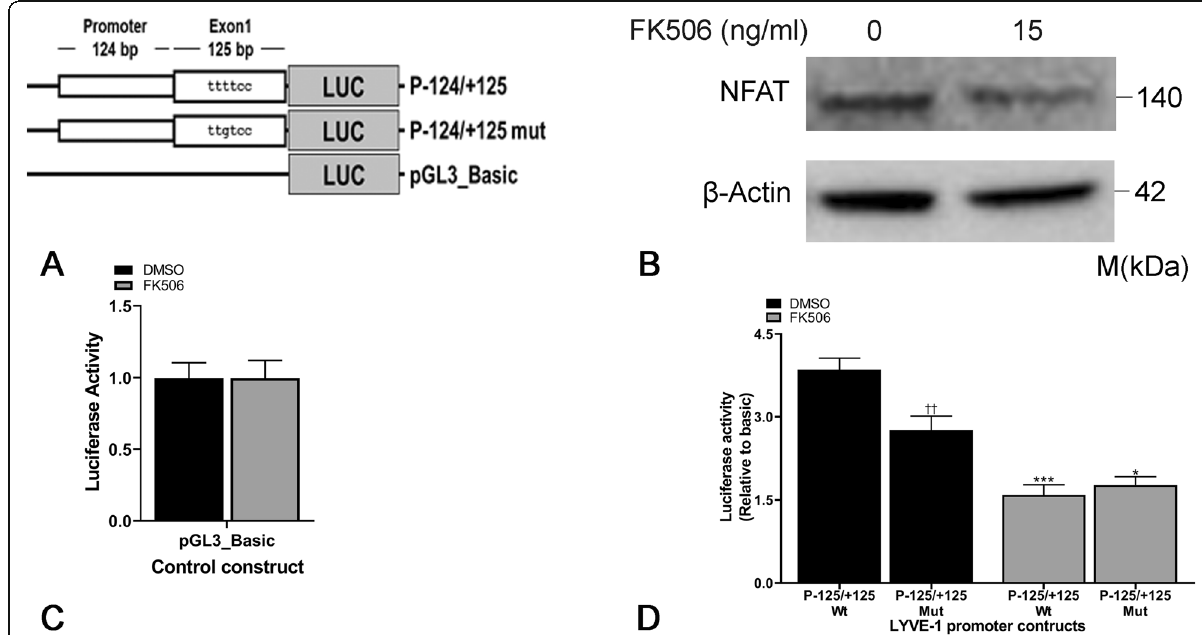
Fig. 4 Luciferase activity of LYVE-1 promoter expression constructs. Schema of pGL3_Basic vector, and wildtype and mutant LYVE-1 luciferase promoter constructs transfected into HEK-293T cells ( a ). Endogenous NFAT expression in HEK-293 T cells ( b ). Luciferase activity of vehicle (DMSO) and FK506 treated HEK-293 T cells transfected with ( c ) pGL3_Basic vector and ( d ) wildtype and mutant LYVE-1 promoter constructs. Each luciferase data is normalized to internal Renilla control. Data for LYVE-1 promoter constructs are presented relative to the pGL3_Basic vector luciferase activity. Average (± standard deviations as error bars) of four independent experiments are presented; each independent experiment for western blotting consisted of three technical replicates. *** p < 0.0001 (between P-125/+ 125 wildtype DMSO vs. FK506), * p < 0.05 (between P- 125/+ 125 mutant DMSO vs. FK506), †† p < 0.001 (between P-125/+ 125 wildtype DMSO vs. P-125/+ 125 mutant DMSO) by 2-way ANOVA (Tukey ’